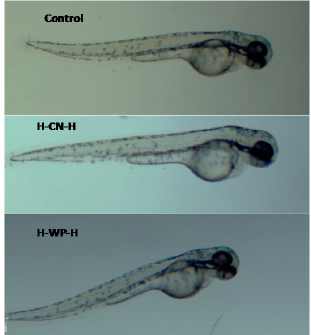
Figure 3. Test of toxicity in zebrafish larvae model incubated with milk proteins for 48 h at 2.5 mg/mL. Control (distillated water), H ‐ CN ‐ H (Hetaed caseines hydrolysate) and H ‐ WP ‐ H (Heated whey protein hydrolysate).